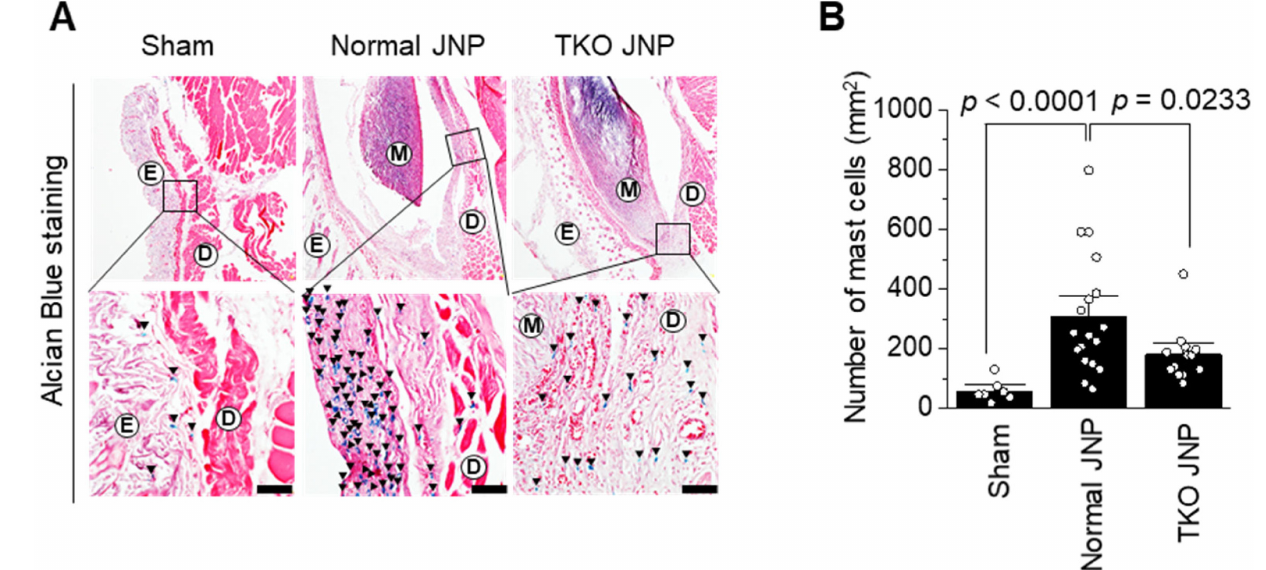
Figure 3. Immunohistochemical analysis of mast cell activation in the sham, normal and TKO JNP groups. The distribution of mast cells was partially confirmed by Alcian blue staining ( A ), and the quantification of mast cells in each group is represented ( B ). In each field, mast cell count for the sham (n, observed field = 7), normal JNP (n, observed field = 18), and TKO JNP (n, observed field = 13) were determined. A two-tailed independent t -test was used for the statistical analysis. E: epidermis; D: dermis; M: meniscus. Magnification (upper panel: 100X, lower panel: 400X). Scale bars: 50 µ